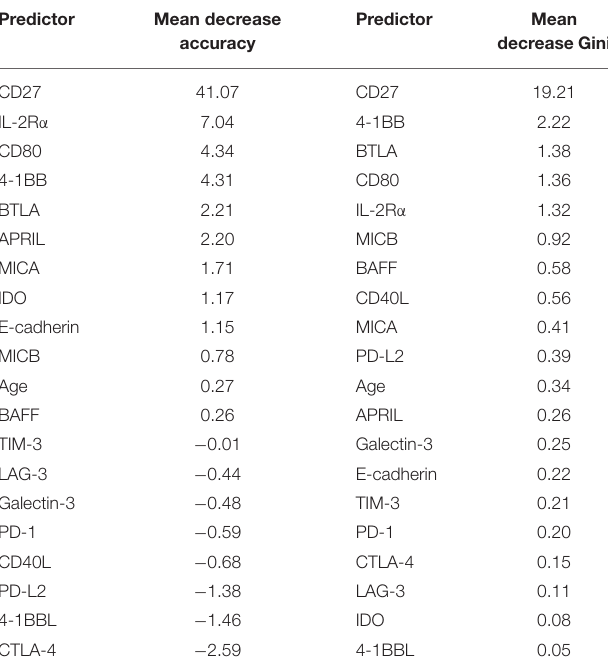
TABLE 7 | Summary of predictors (analytes) with the highest variable importance in serum, assessed both in terms of mean decrease in accuracy and mean decrease in Gini impurity.